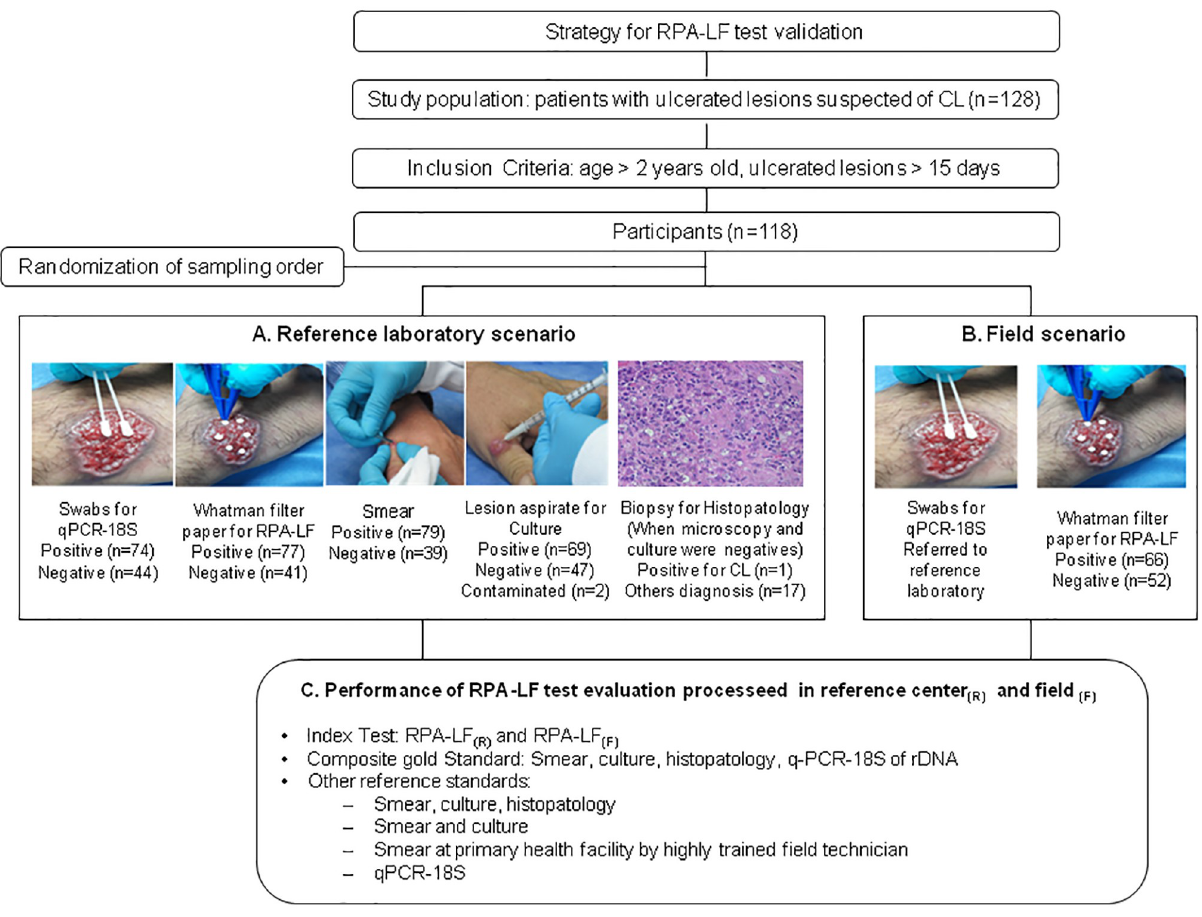
Fig 1. Schematic summary of patient enrollment, and subsequent, sampling, diagnostic procedures, and performance of RPA-LF evaluation in two scenarios. A) Reference lab scenario: samples were obtained by highly trained field technician in Tumaco and processed in a reference center in Cali. In Cali samples were obtained and processed by an expert microbiologist. B) Field scenario: samples were obtained by trained community health workers (CHW), RPA-LF was processed by a non-expert field technician in Tumaco in primary health facility (PHF), and swabs were sent to reference center to be processed. C. Performance of RPA-LF